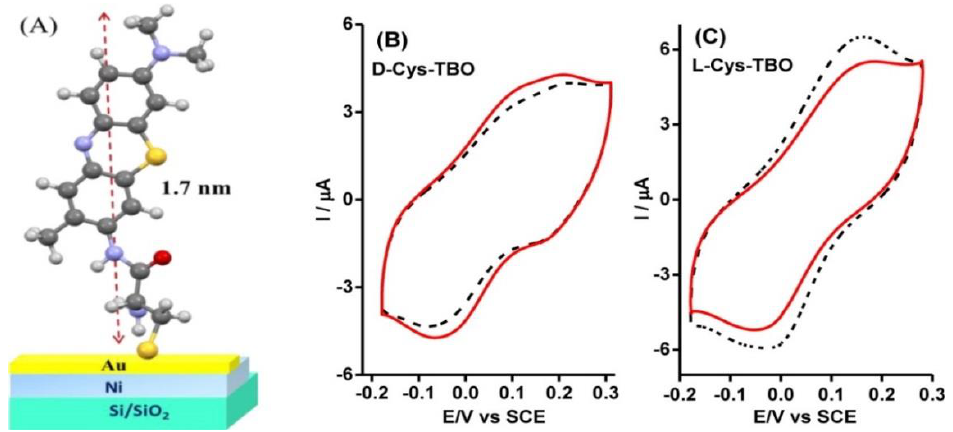
Figure 11. (a) Schematic description of covalently bonded toluidine blue O (TBO) to the self-assembled monolayers (SAMs) of L or D cysteine prepared on 10 nm Au-coated Ni working electrode, (b) spin-dependent cyclic voltammograms of D-cys-TBO, and (c) L-cys-TBO self-assembly grafted on Au-overlayer-coated Ni electrode. The voltammograms were recorded in 0.1 M PBS of pH 7.4 containing 10 mM KCl as supporting electrolyte at 50 mV s −1 (Reproduced with permission from [34], American Chemical Society, 2015).